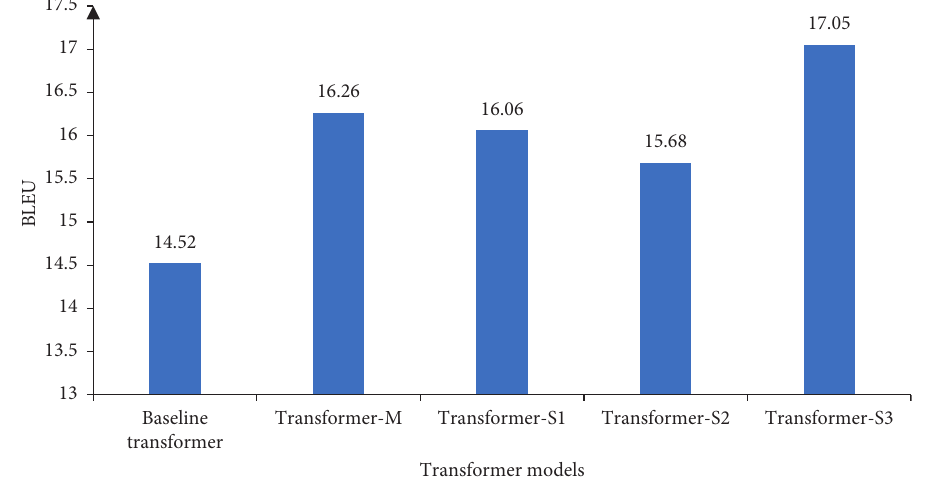
Figure 1: Translation results by transformer Table 7: Translations of a Vietnamese sentence comprising 10 tokens.